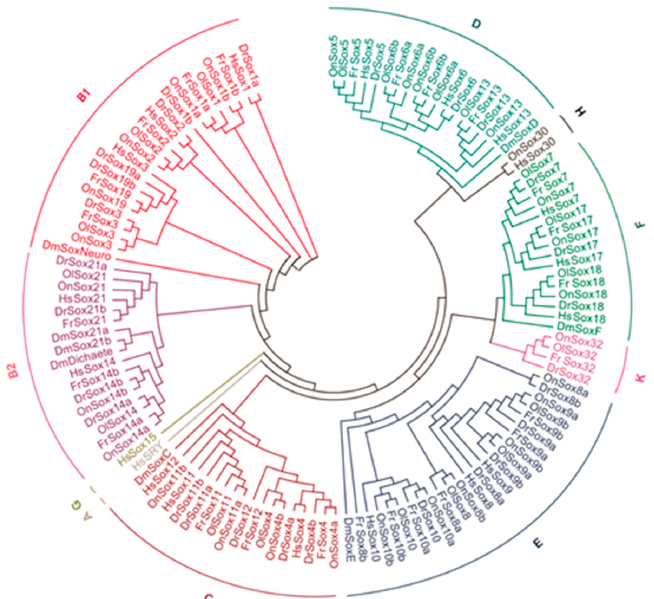
Figure 3. Phylogenetic tree of the Sox proteins from the tilapia and the other animals. The amino acid sequences of the HMG-box domain of the Sox proteins were used to build a neighbor-joining phylogenetic tree of the Sox genes by using MEGA 6.0 program. The sources of the sequences were described in the Materials and Methods Section. On: Oreochromis niloticus ; Ol: Oryzias latipes ; Dr: Danio rerio ; Fr: Fugu rubripes ; Hs: Homo sapiens ; Dm: Drosophila melanogaster .